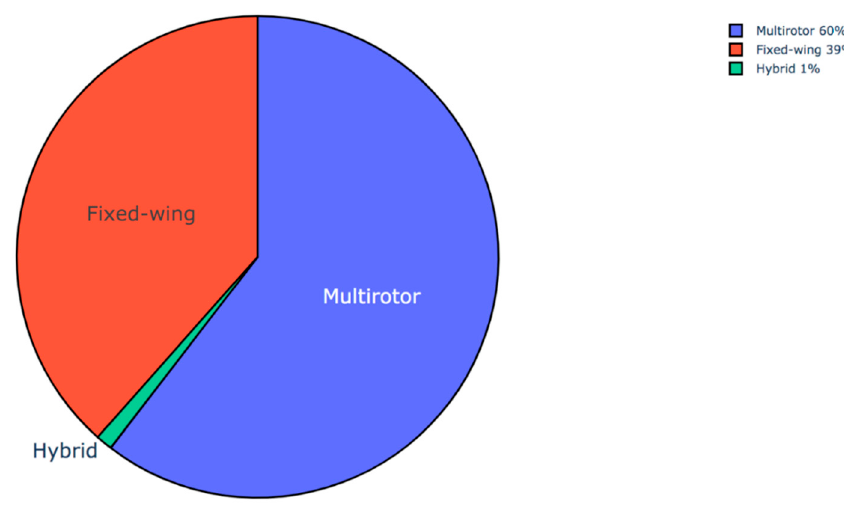
Figure 3. The UAV hardware technology used by the studies. Percentages indicate the frequency of use surveyed from the studies. All platforms were included for studies that employed multiple UAV types.